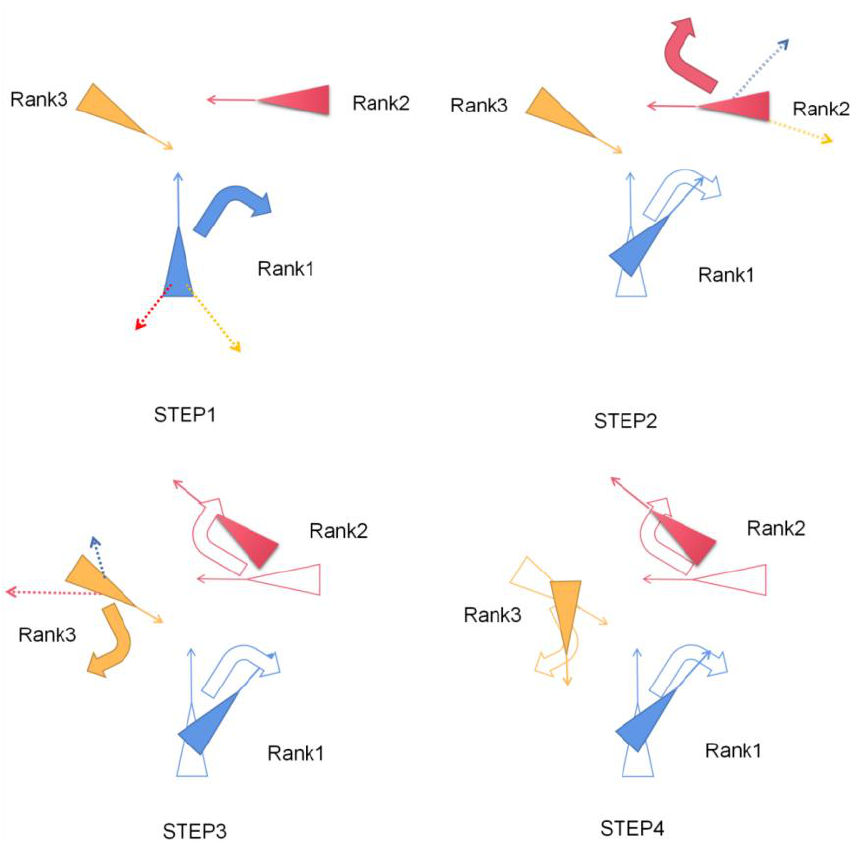
Figure 18. Multi-ship encounter decision-making process. Assume that the coordinates of the ship at this time are q = ( x , y ) T , then the resultant force field constructed by APF (Artificial Potential Field) can be expressed as: